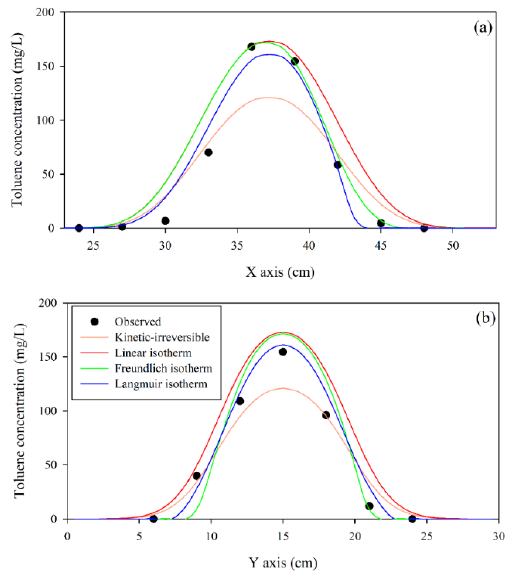
Figure 6. Concentration distribution of toluene plume: ( a ) X-axis direction (y = 15 cm); ( b ) Y-axis direction (x = 39 cm).